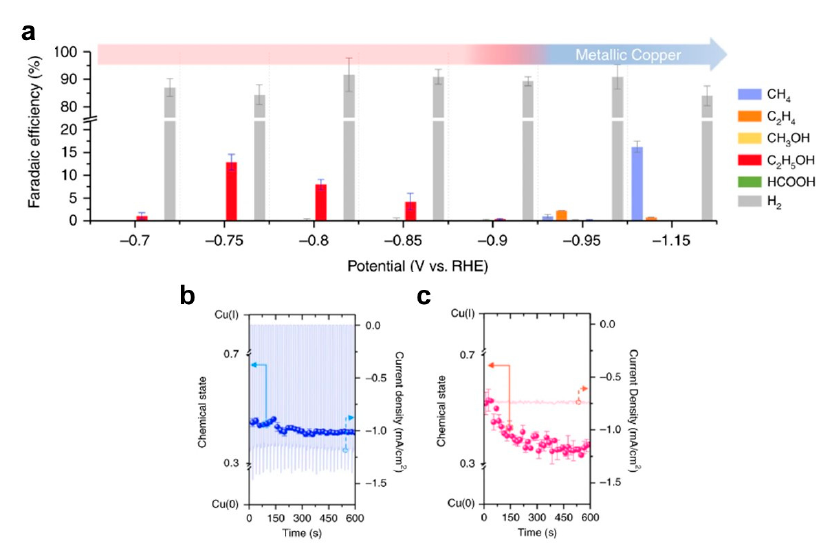
Figure 11. The effects of using a redox shuttle (i.e., an electrolyte additive capable of reversible oxidative-reductive reaction at a specific potential): ( a ) the potential dependence of the CO 2 RR product selectivity of the CuO x catalyst in 0.5 M CO 2 -saturated KHCO 3 when using a redox shuttle. The error bars represent the standard deviation based on three individual measurements; ( b ) the time-resolved variations in the Cu species in CuO x and the corresponding electrochemical responses during the CO 2 RR at − 0.75V when using a redox shuttle; ( c ) for comparison, the time-resolved variations in the Cu species in CuO x and the corresponding electrochemical responses during the CO 2 RR at − 0.75V, obtained using chronoamperometry (reproduced with permission from ref. [6], copyright 2020, Springer Nature).